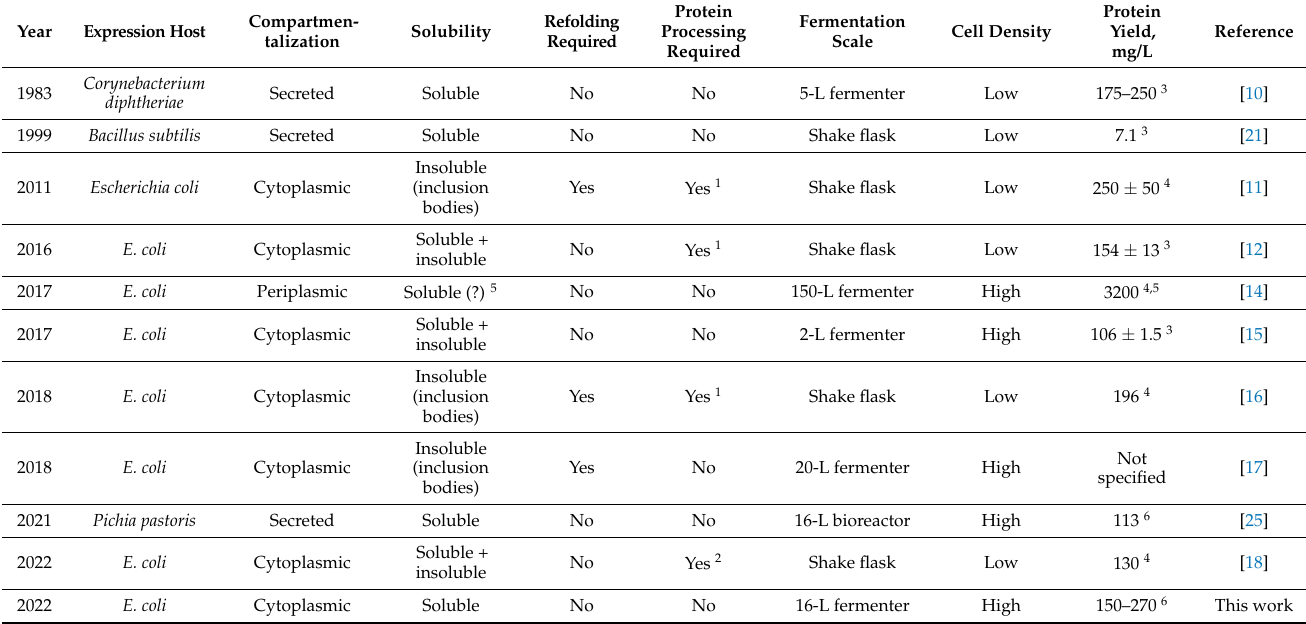
Table 2. Peer-reviewed articles focused on CRM197 expression and